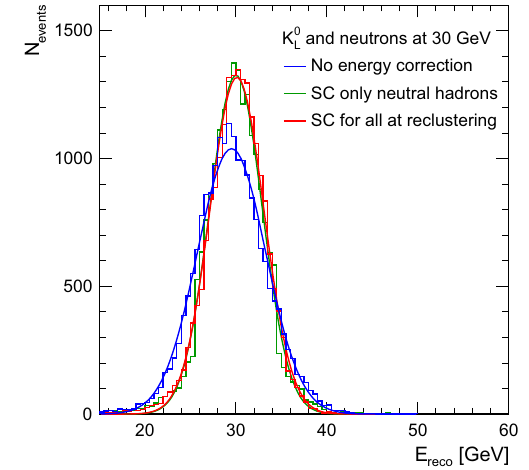
Fig. 4 Distribution of energy sum of all PFOs for neutrons and K 0 30GeV:withoutenergycorrection(blue),whenapplyingSCforneutral cluster at PFO level (green) and when applying SC at the reclustering step for all clusters (red)